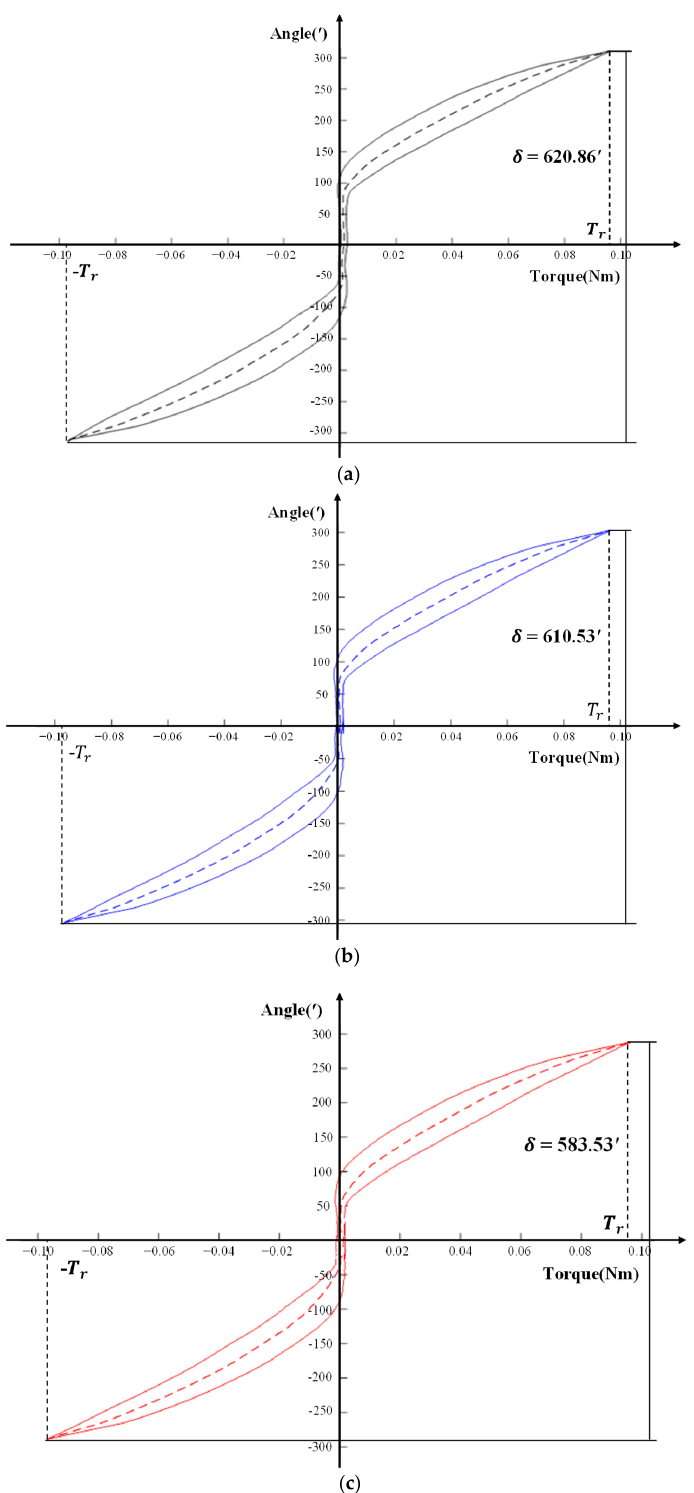
Figure 18. Hysteresis curve of reducer 3 during the first test at three positions of 0°, 180° and 360°. ( a ) 0.01 Nm/s and 0°; ( b ) 0.05N m/s and 180°;. ( c ) 0.1N m/s and 360°. Table 10. Experiment results of 𝛿 .